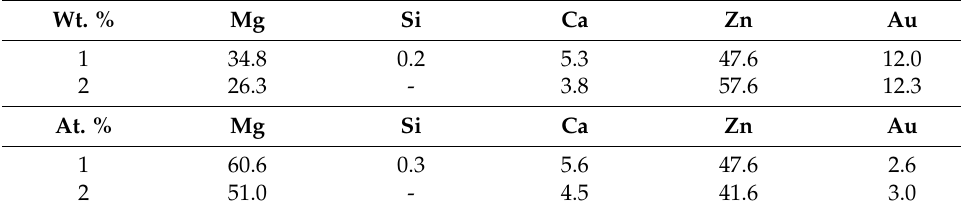
Figure 3. The SEM images of the Mg 63 Zn 30 Ca 4 Au 3 powder after 13 h milling. Both images represent powder samples with different magnifications: ( a ) 500× and ( b ) 150×, the number in the images refer to the analysis results presented in Table 2. Table 2. EDS results from the area marked in Figure 3.